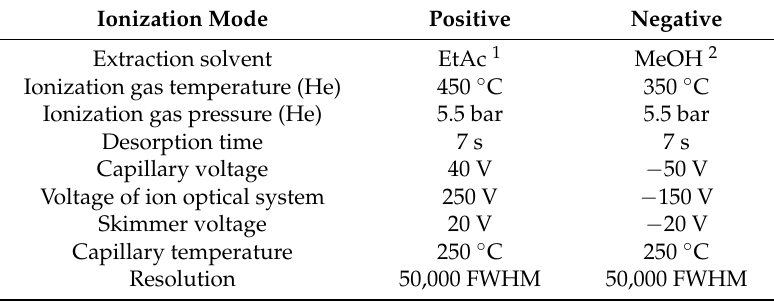
Table 6. Optimized conditions used for DART-Orbitrap-MS